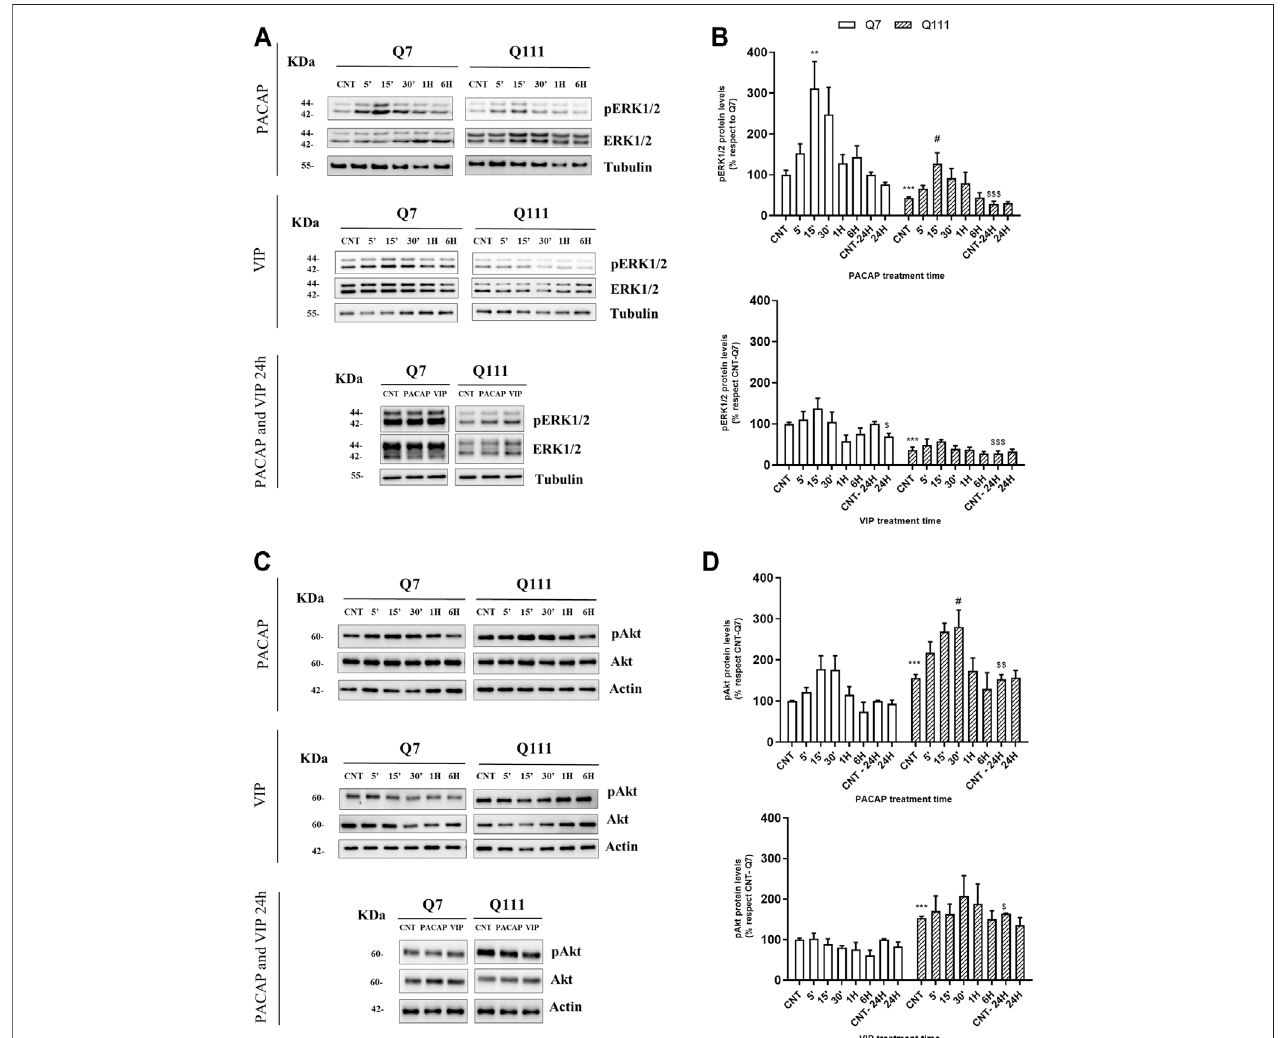
FIGURE5| PACAPbutnotVIPtreatmentpromotesthephosphorylationofERKandAkt.STHdhQ7/Q7(Q7)andSTHdhQ111/Q111(Q111)cellsweretreatedwith PBS(CNT),PACAP(10-7M)orVIP(10-7M)for5,15,30 minutes,1,6and24 hours.Proteinlevelsof (A) pERK1/2and (C) pAkt(Ser473)wereanalyzedbyWesternblot. Quanti fi cation of (B) pERK and (D) pAkt was performed. As no changes were detected in ERK and Akt levels, results (mean ° SEM; n ° 4) were normalized to the loading control tubulin or actin and are expressed as a percentage respect to CNT-Q7 cells. Representative immunoblots are shown. Differences in protein basal levels betweenCNT-Q7andCNT-Q111cellswereanalyzedbyunpairedStudent ’ st-test.TheeffectofPACAPandVIPtreatmentsfor24 hourswasanalyzedbyusingthetwo- way ANOVA test followed by Tukey as post-hoc test. Treatment response over time was analyzed separately in each cell type using one-way ANOVA followed by Dunnett as post-hoc test. When variances between groups were not equal Welch ’ s correction was applied. * p < 0.05 and *** p < 0.001 as compared to CNT-Q7 cells; # p < 0.05 as compared to CNT-Q111 cells; $ p < 0.05, $$ p < 0.01, and $$$ p < 0.001 as compared to CNT-24H-Q7 cells.